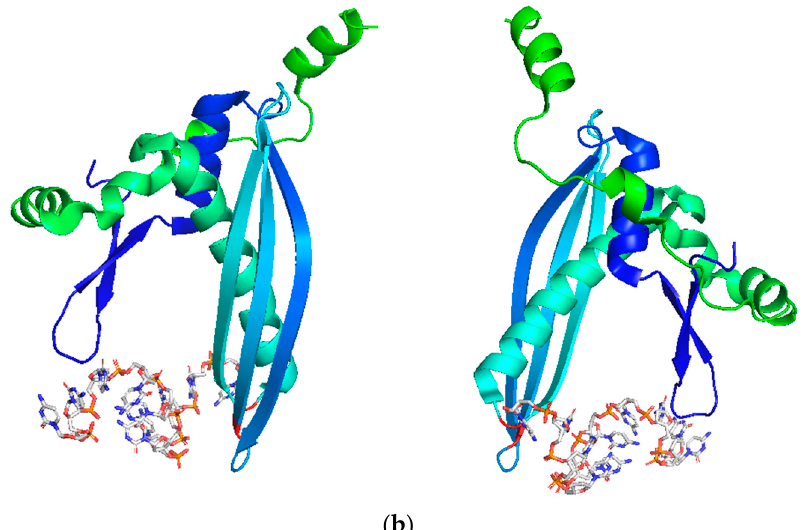
Figure 8. ( a ) Two views of the RAD52 (1–212) monomer in complex with an ssDNA molecule inside its inner binding cleft (PDB 5XRZ); ( b ) two views of the RAD52 (1–212) monomer in complex with an ssDNA molecule inside its outer binding cleft (PDB 5XS0). Structures were prepared using UCSF Chimera